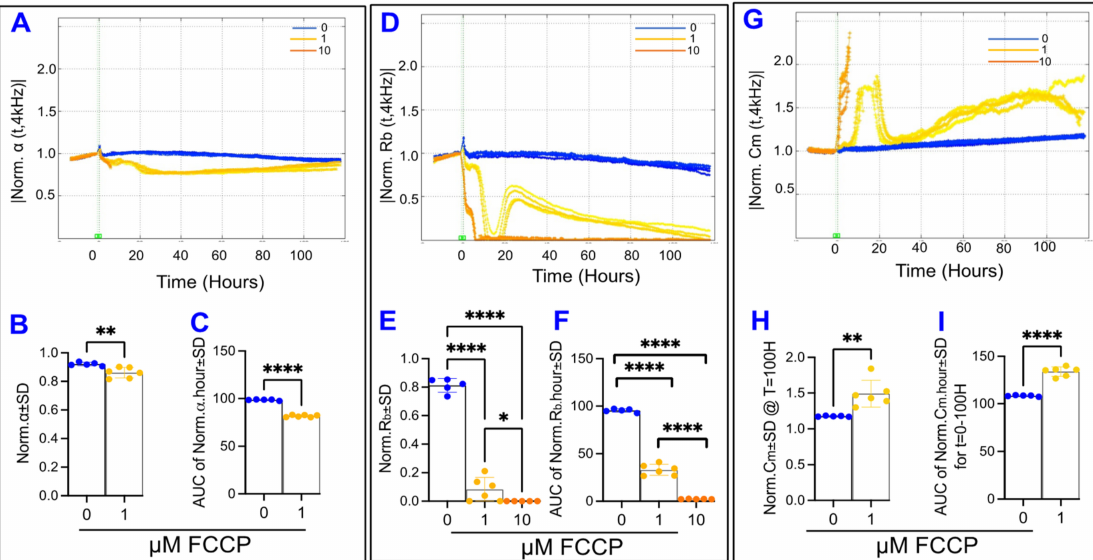
Figure 8. Real-time measurement of α , R b , and C m in ARPE-19 cells in a state of OxPhos uncoupling. ( A ) Normalized α measured at 4000 Hz vs. time (T) for the interval from the start of treatment at T = 0–100 h after initiation of treatment with an FCCP concentration of 0, 1, or 10 µ M. The α curves for the FCCP 10 µ M cell group all abruptly end around the 5.1-h mark, as this is the time when the R b curves for the FCCP 10 µ M group reach zero. The ECIS software is unable to calculate a positive integer for α at times when R b has a value of zero. By this 5.1-h mark, the endpoint α values and the area under the curve (AUC) of α are significantly different between each FCCP group and control. These data are not shown in the figure. ( B ) End-point values for the control and FCCP 1 µ M groups normalized α at the end of the experiment, where FCCP 1 µ M has decreased from the control. ( C ) AUC of normalized α for the interval T = 0–100 h for the groups FCCP 0 (Control) and 1 µ M. Throughout the total experiment, the FCCP 1 µ M group demonstrates a difference in behavior from the control group. ( D ) Normalized R b measured at 4000 Hz vs. time (T) for the interval from the addition of treatment at T = 0 to 100 h afterward. The R b curves for the FCCP 10 µ M cell group reach zero around the 5.1 h mark. ( E ) R b experiment endpoint comparisons for all three groups, where a dose-dependent effect on end R b is seen. ( F ) AUC of normalized R b for the time from treatment start to experiment end. FCCP treatment demonstrates a dose-dependent reduction in R b . ( G ) Normalized C m measured at 4000 Hz vs. time (T) for the interval from the start of treatment at T = 0 to 100 h after initiation of treatment with an FCCP concentration of 0, 1, or 10 µ M. The C m curves for the FCCP 10 µ M cell group all abruptly end around the 5.1 h mark, as this is the time when the R b curves for the FCCP 10 µ M group reach zero. The ECIS software is unable to calculate a positive integer for C m at times when R b has a value of zero. At this 5.1 h mark, the endpoint C m values and the area under the curve (AUC) of C m are significantly different between FCCP 10 µ M and FCCP 0 but not between FCCP 10 µ M and Control. These data are not shown in the figure. ( H ) Comparison of C m at the experimental endpoint of T = 100 h for the control and FCCP 1 µ M groups, where FCCP 1 µ M has resulted in an endpoint difference from FCCP 0. ( I ) AUC of normalized C m for the interval T = 0–100 h for the groups FCCP 0 and 1 µ M. Throughout the experiment, the FCCP 1 µ M group demonstrates a difference in C m behavior from the control group. Statistical comparison analysis in ( B , C , H , I ) done using two-tailed unpaired t -tests. Statistical comparison analysis in ( E , F ) done using the ANOVA test followed by Tukey post hoc test to make the comparisons. Abbreviations: Norm, normalized; AUC, area under the curve; ns, no significance. Data shown are the mean ± SD of 5–6 independent biological replicates per group. p values are * p ≤ 0.05, ** p ≤ 0.01, and **** p ≤